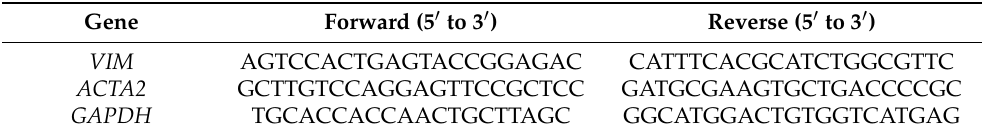
Table 1. Sequences of qPCR